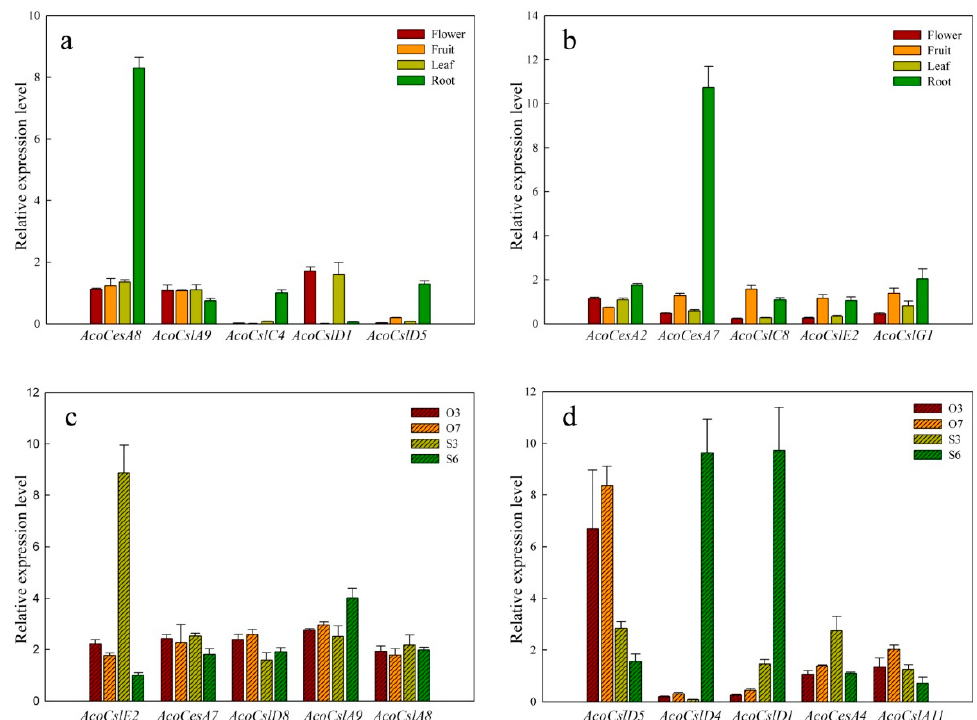
Figure 6. Expression profiles of the pineapple Ces/Csl genes in different tissues. ( a , b ) qPCR expression profiles of AcoCes/Csl genes in flower, fruit, root and leaf of pineapple. ( c , d ) qPCR expression pattern of AcoCes/Csl genes in developing ovule and stamen of pineapple. Sample details are mentioned at the top right corner: Ovule O3 and O7, stamen S3 and S6. The number after the different samples name refers to the different developmental stages. The gene details are mentioned at the bottom of each lane. Data were normalized to the EF1a gene. Vertical bars indicate standard error (SE). All experiments were performed with three technical and three biological repeats. The prefix ‘Aco’ indicates Ananas comosus .